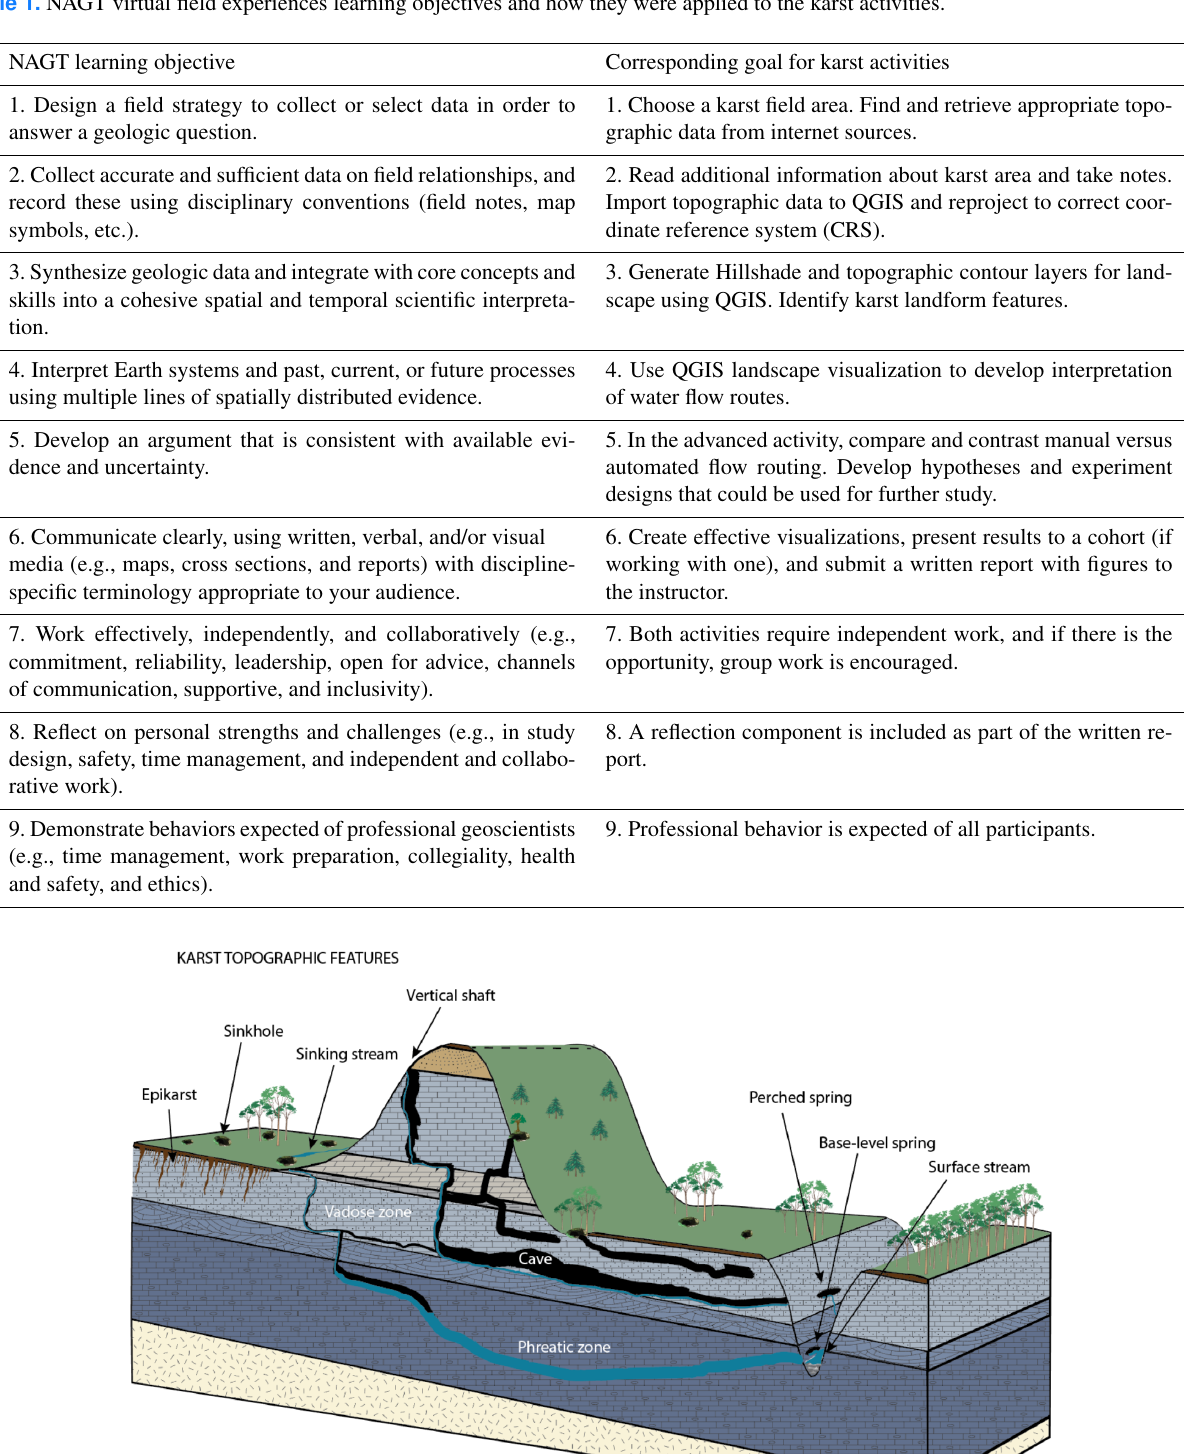
Table 1. NAGT virtual field experiences learning objectives and how they were applied to the karst activities.